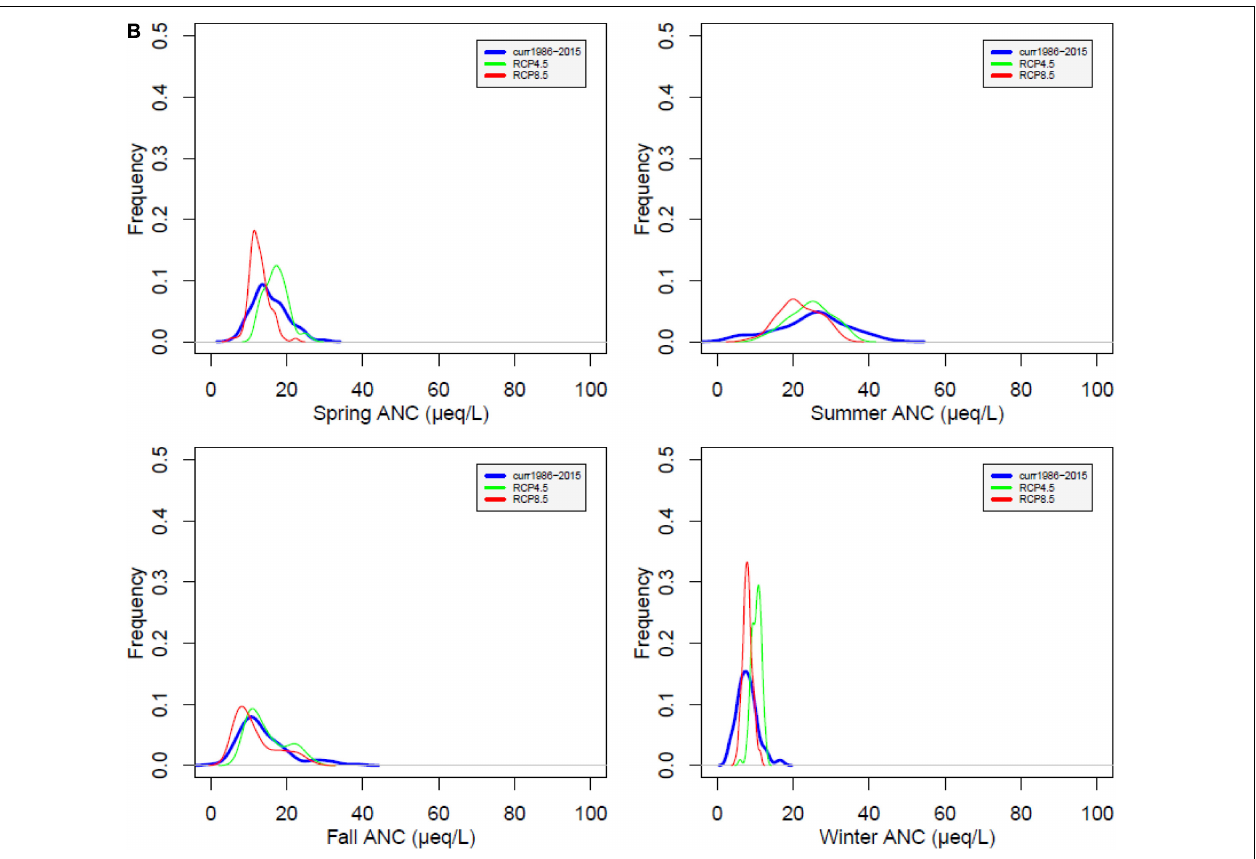
FIGURE 7 | Probability distribution of simulated acid neutralizing capacity (ANC) at WS18 (A) and WS27 (B) under future climate compared to values under current climate by season. Current (blue), RCP4.5 (green), and RCP8.5